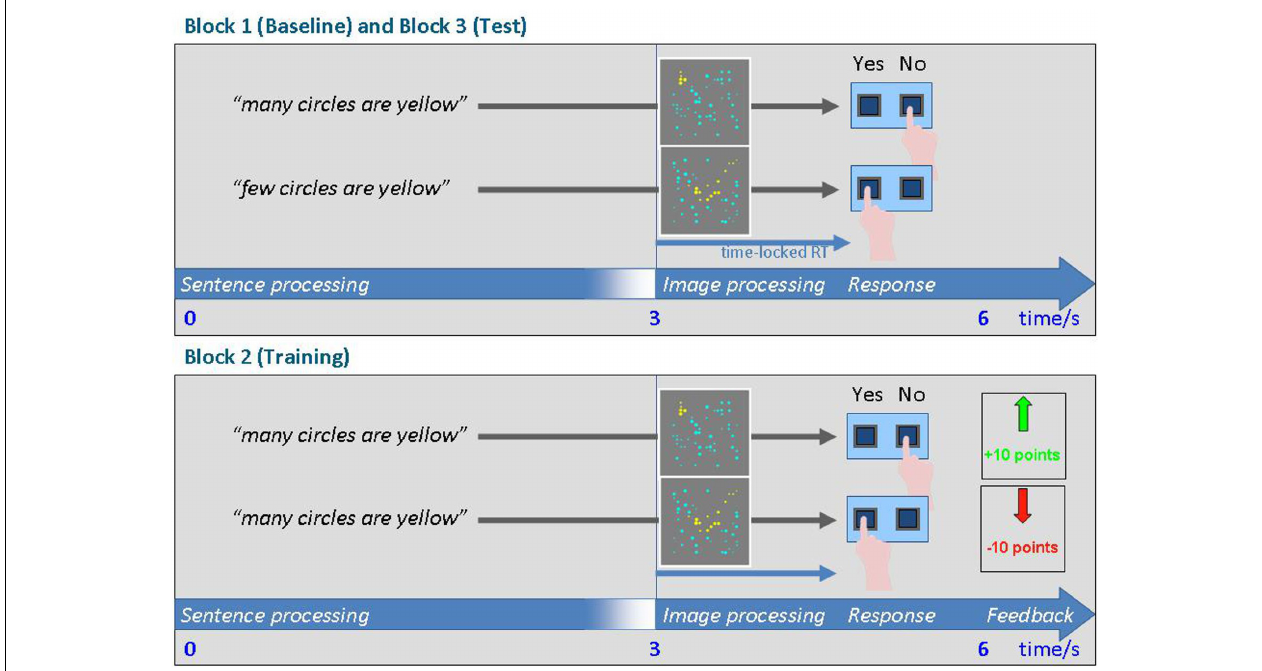
FIGURE 1 | Schematic of the trials in blocks 1 and 3 (top) and in the adaptation block 2 (bottom) . Source: Heim et al. (2015). If so many are “few,” how few are “many”? Frontiers in Psychology, 6, 441. Copyright lies with the